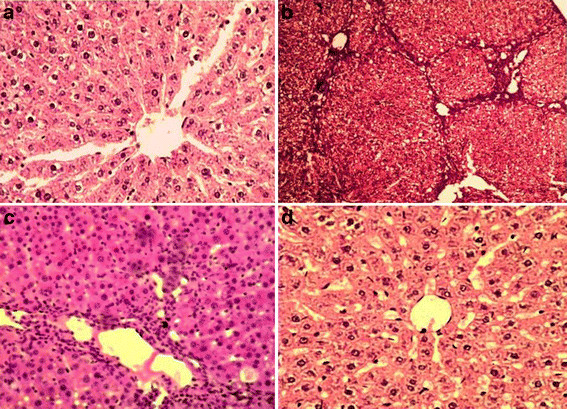
Histopathological changes caused by CCl4and preventive effect of chloroform extract ofLaunaea procumbensin different groups. Control (a), CCl4(b, c), 200 mg/kg b.w., LPCE + CCl4(d).